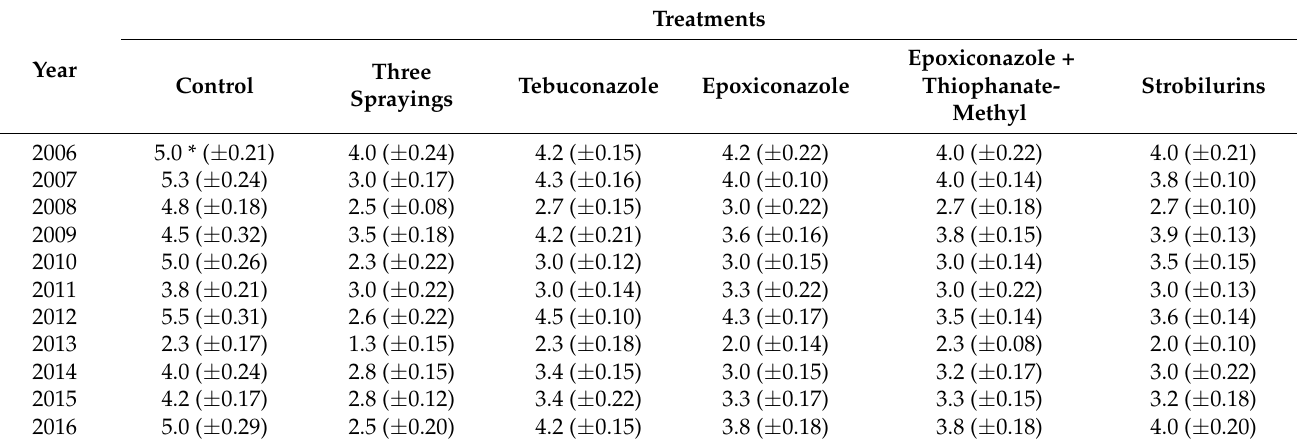
Table 4. Degree ( ± SD) of leaf infestation by diseases (9-point scale evaluation * before harvest).